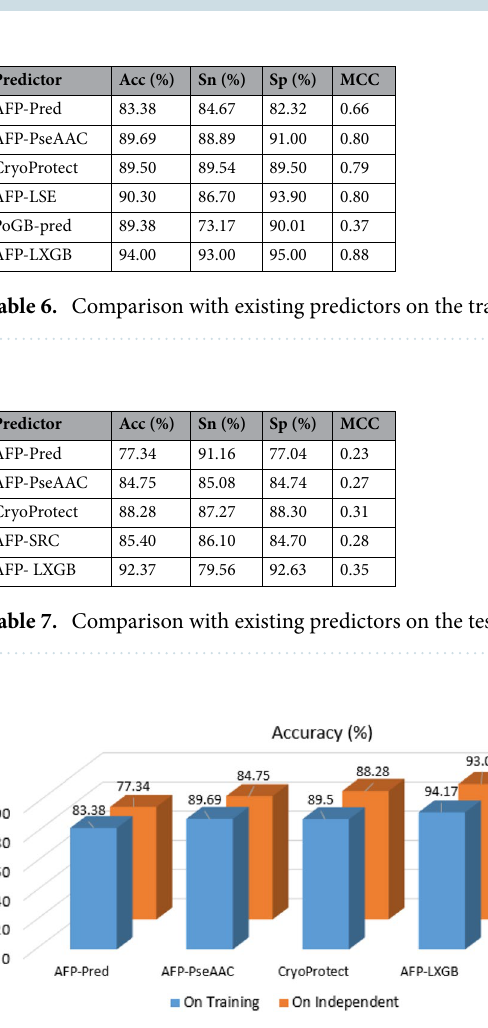
Figure 3. Accuracy comparison with the existing